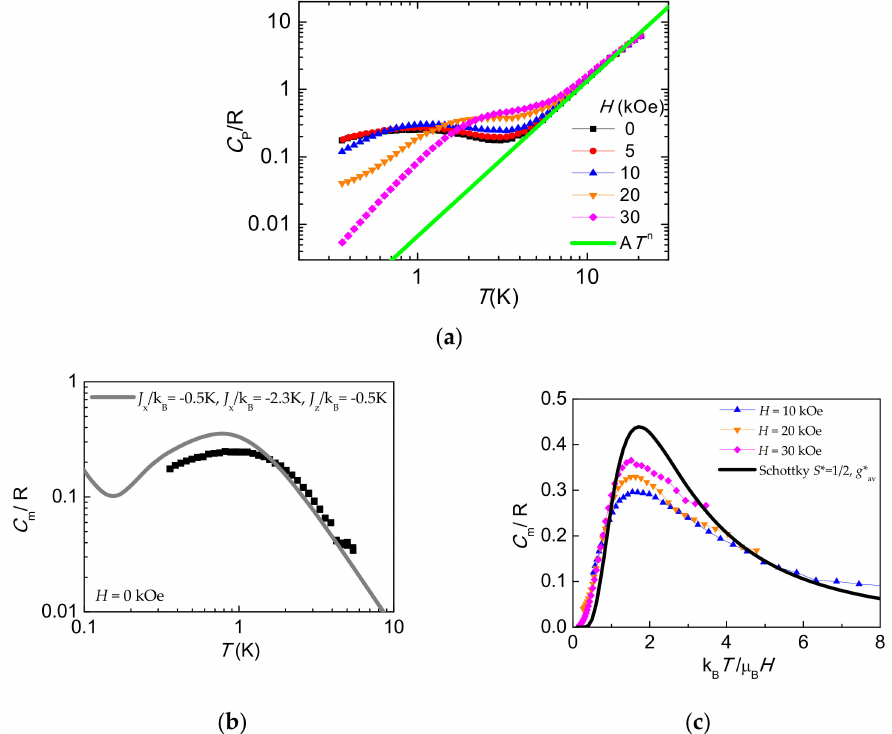
Figure 6. ( a ) Heat capacity as a function of temperature for various applied fields for compound 1 . The lattice contribution is depicted by the solid green line. ( b ) Magnetic contribution to the heat capacity as a function of temperature for H = 0. The solid grey line is the simulated C m ( T ) curve as obtained within the dimer model given in Equation (3), with anisotropic AF exchange constants, J * x /k B = − 0.5 ± 0.05 K, J * y /k B = − 2.3 ± 0.3 K, and J * z /k B = − 0.5 ± 0.05 K plus a hyperfine contribution. ( c ) Magnetic heat capacity contribution as a function of the adimensional x = k B T / µ B H . Continuous black line: calculated two-level Schottky curve with g * av =